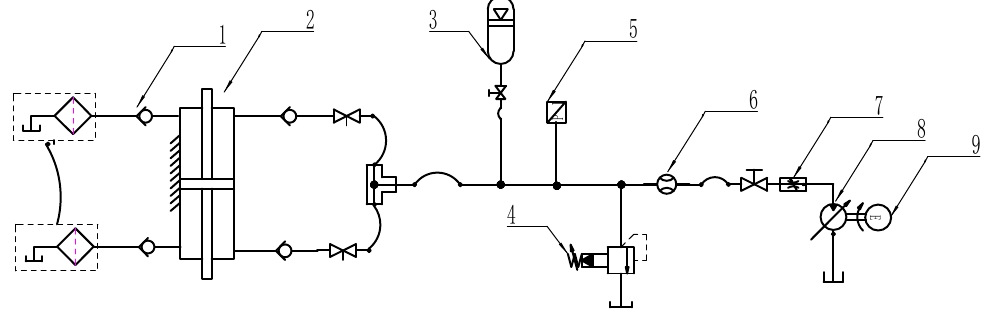
Figure 2. Working principle of the hydraulic transmission